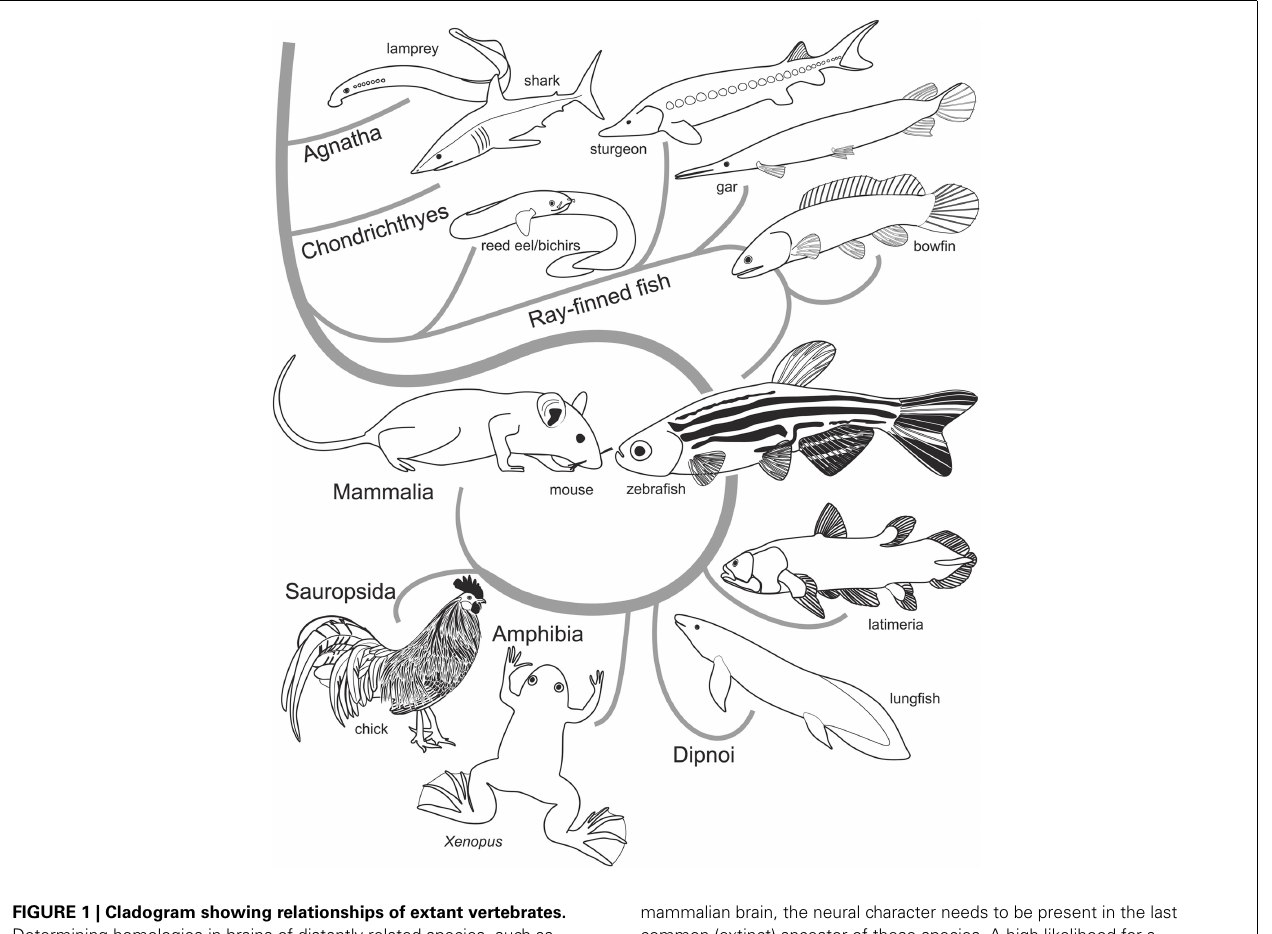
FIGURE 1 | Cladogram showing relationships of extant vertebrates. Determining homologies in brains of distantly related species, such as zebrafish (teleosts) and mouse (mammals), relies on comparative knowledge in regard to the ancestral situation provided by outgroup comparisons (Hennig, 1966).That is, to establish a neural character in zebrafish as homologous to a topologically corresponding structure in the